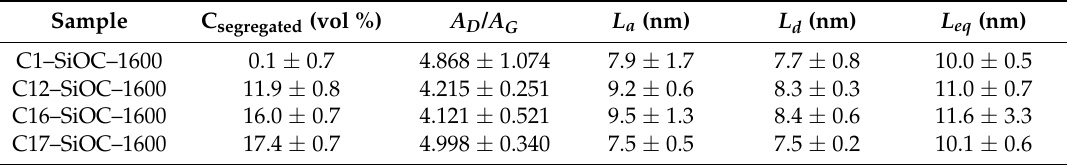
Table 2. Indicators for the degree of graphitization of the segregated carbon phase in the prepared SiOC glass